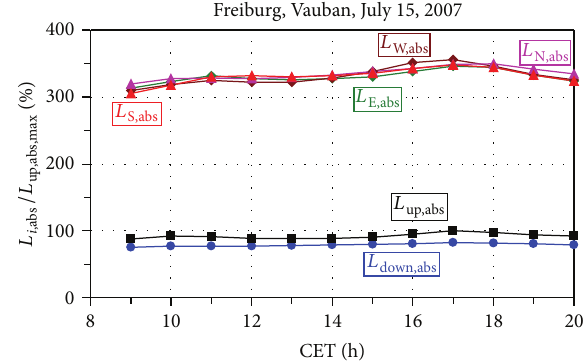
Figure 8: 1h mean values of the short-wave radiant flux densities 𝑖 = down, up, E, S, W, and N) from the three-dimensional 𝐾 𝑖, abs ( environment absorbed by the human-biometeorological reference person, related to the 1h peak value of 𝐾 28 W/m 2 ), NNE-facing sidewalk of a WNW-ESE street canyon, summer day.